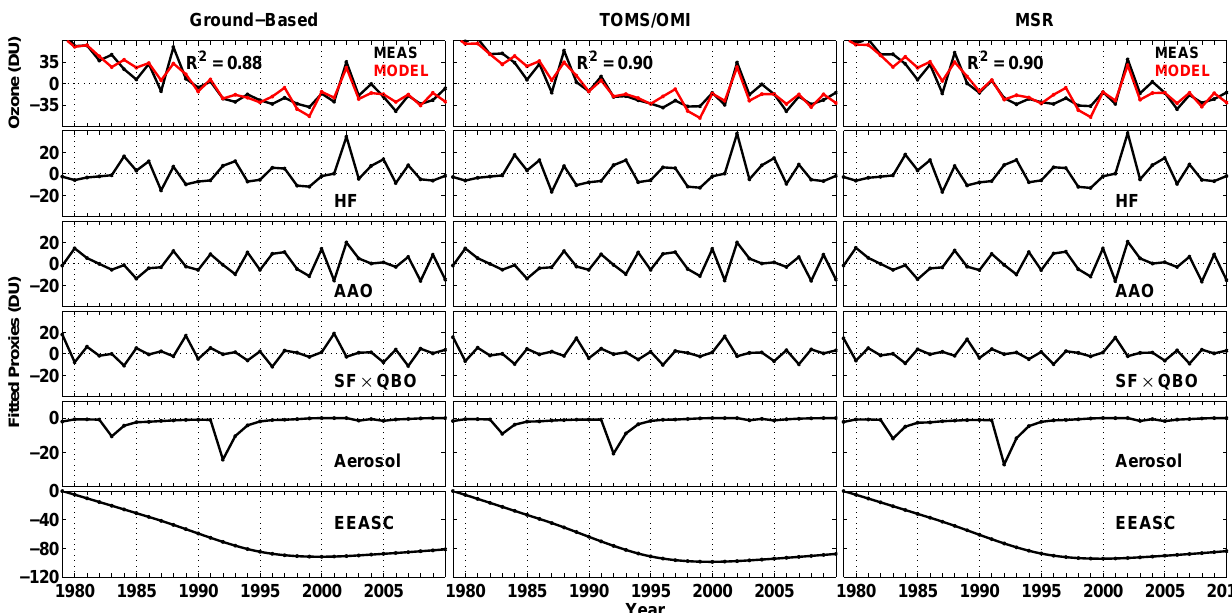
Fig. 5. The vortex averaged September–November O 3 trends estimated using a multi-variate regression model for the ground-based, TOMS/OMI, and MSR data in 1979–2010. Top to bottom: deseasonalised O 3 (MEAS) and the regression model (top panel), the contri- bution of heat flux – HF (second panel), Antarctic Oscillation – AAO (third panel), solar flux (SF) multiplied by quasi-biennial oscillation (QBO) at 40hPa (fourth panel), aerosol (fifth panel), and the equivalent effective Antarctic stratospheric chlorine – EEASC (bottom panel).